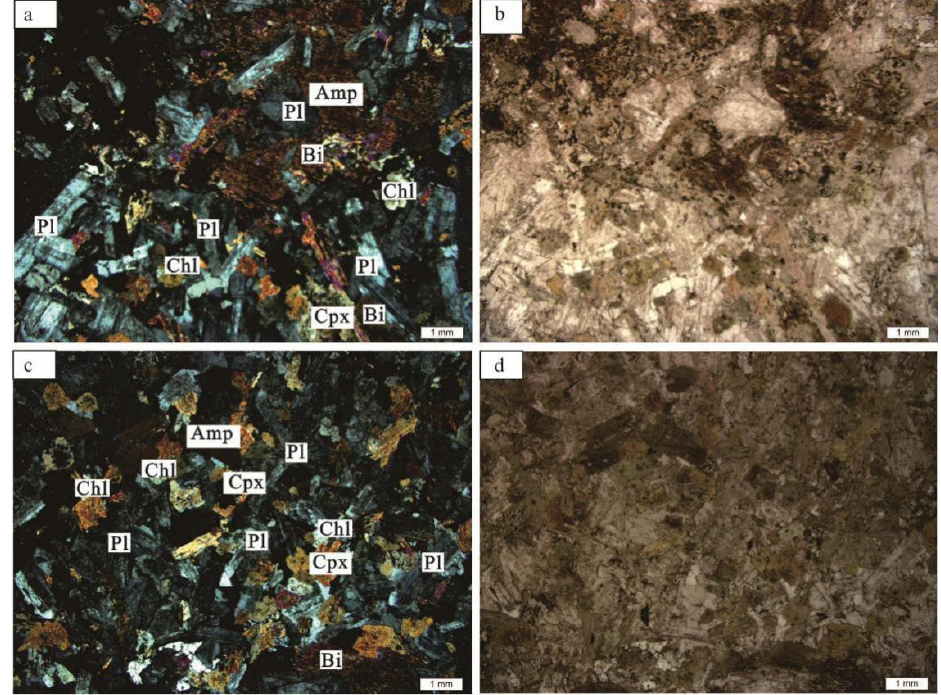
Figure 4. Microphotographs of gabbro samples in Akechukesai Ⅳ mafic–ultramafic complex. Mineral code: Cpx = clinopyroxene, Pl = plagioclase, Amp = amphibole, Bi = biotite. a and c:crossed polars; b and d:parallel polars.